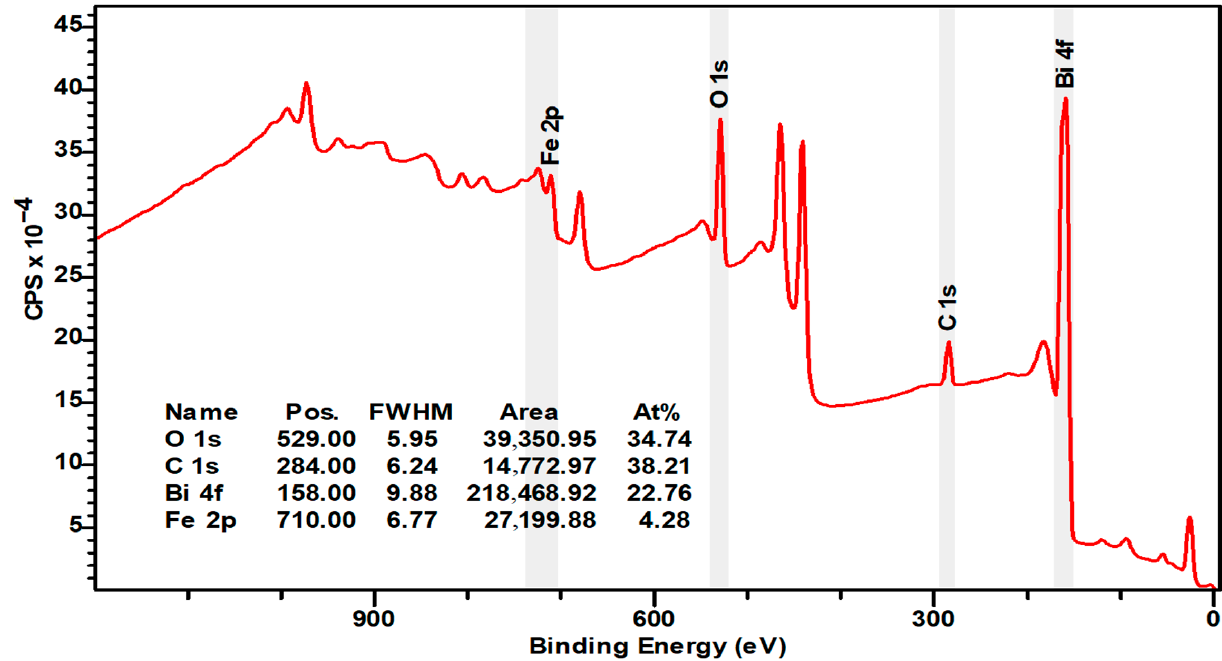
Figure 4. Wide XPS spectrum of 100 nm BFO (Pt/TiO 2 /Si) sample.